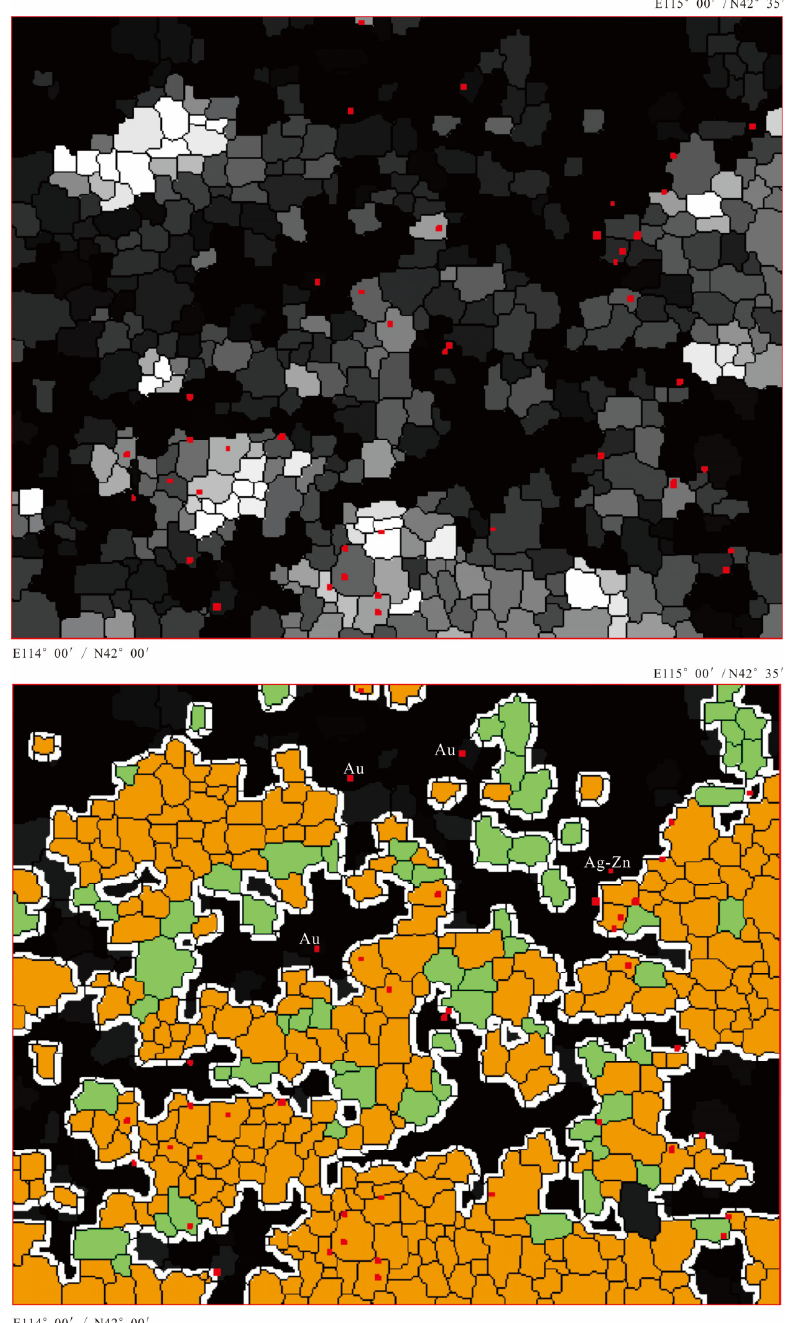
Figure 9. (upper) the object-based anomaly-score base map with known I-series ore spots (red squares) overlaid on it. The image objects with larger scores are represented by brighter tones, while image objects with smaller scores are represented by darker tones. (lower) the delineated anomalous regions (green-colored patches—Level II anomalies, orange-colored patches—Level I anomalies, delineated by the 60% quantile) with ore spots overlaid on it. We also created a 4-pixel buffering zone (white colored belts) around the known anomalous regions. Note: the mineral species include Cu, Au, Fe, Mo, Hg, Ag-Pb-Zn-Fe, Ag-Pb-Zn, Pb-Zn, Cu-Zn, Ag-Pb, Pb, Zn, and U. In the lower picture, the ore spots not falling in the anomalous objects are labelled with their mineral species. The size of the ore spots is proportional to the mineralized scale ranging from mineralized spots to small- and medium-scaled ore deposits. Actually, most of the ore spots shown in Figure 9 are mineralized spots, namely micro-mineralization outcrops. The ore-spot data are provided by reference [29].